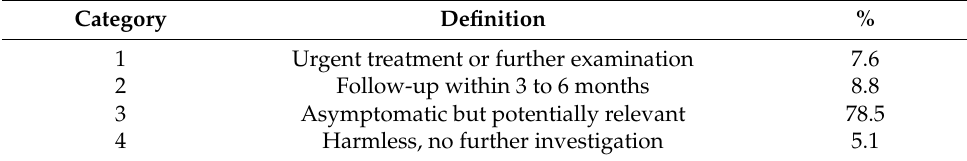
Table 3. Proportion of incidental findings per category according to [8].